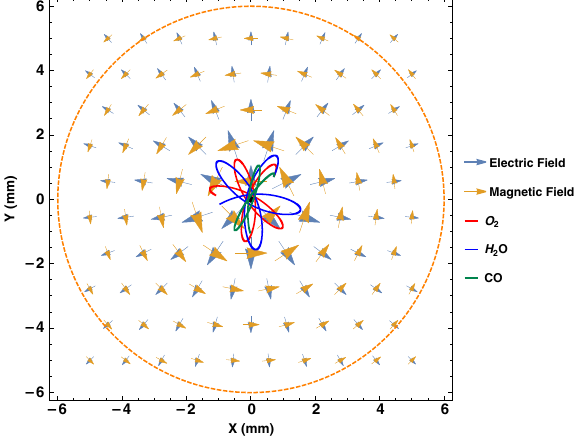
FIG. 8. The motion of neutral oxygen, water and carbon monoxide molecules initially at 1 mm from the beam with a thermal velocity corresponding to a temperature of order 1 mK, and subjected to the electromagnetic field of a beam, in the ¼ transverse plane. The initial thermal velocities were for O 2 v th 0 . 2 m = s (0.1 mK), for water v ¼ 3 m = s (20 mK), and for CO th v ¼ 0 . 3 m = s (0.3 mK). th